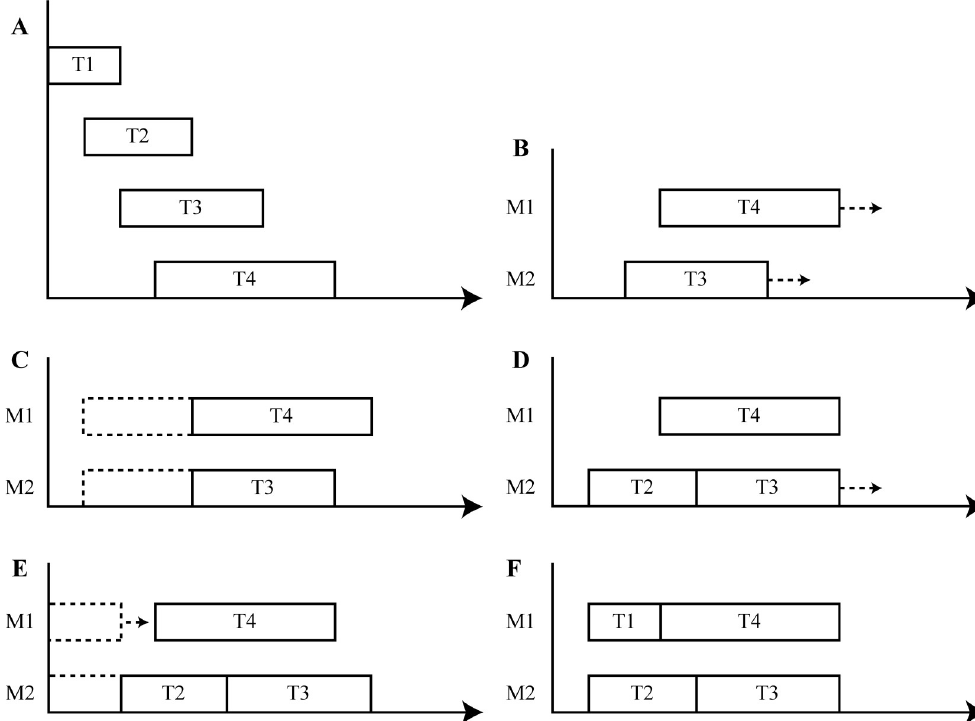
Fig 6. SSPA schematic diagram where M1 and M2 are SPMS and T1 − T4 are tasks. (a) Simple example, (b) allocation of T3 and T4, (c) attempted allocation of T2, (d) assignment of T2 to SPM M2, (e) attempted allocation of T1, and (f) completed